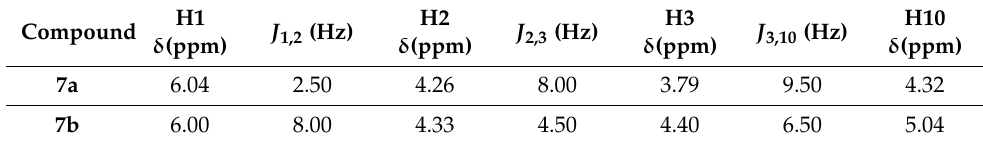
Table 1. Chemical shifts and coupling constants for protons of new formed pyrrole ring in com- pounds 7a , b.